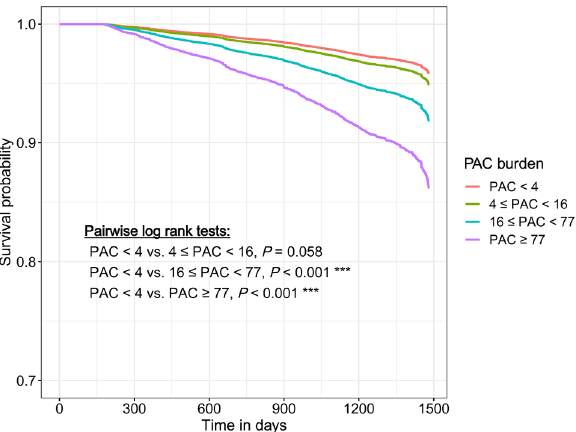
Figure 2. Survival curve of the study subjects. Compared to 1st quartile, higher PAC burden groups (quartile 3rd and 4th) had significantly lower survival probability. Abbreviation: PAC, premature atrial